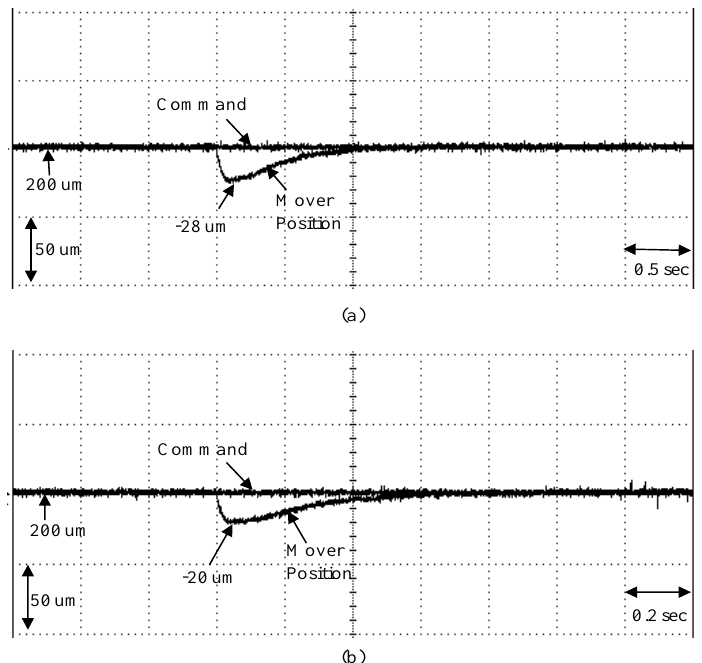
Figure 11. Experimental results of measured mover position response under the step force disturbance with adding load f L = 2 N in the 200um: ( a ) for the micrometer backstepping control system using switching function with upper bound; ( b ) for the micrometer backstepping control system using an amended recurrent Gottlieb polynomials neural network and AACO with the compensated controller.